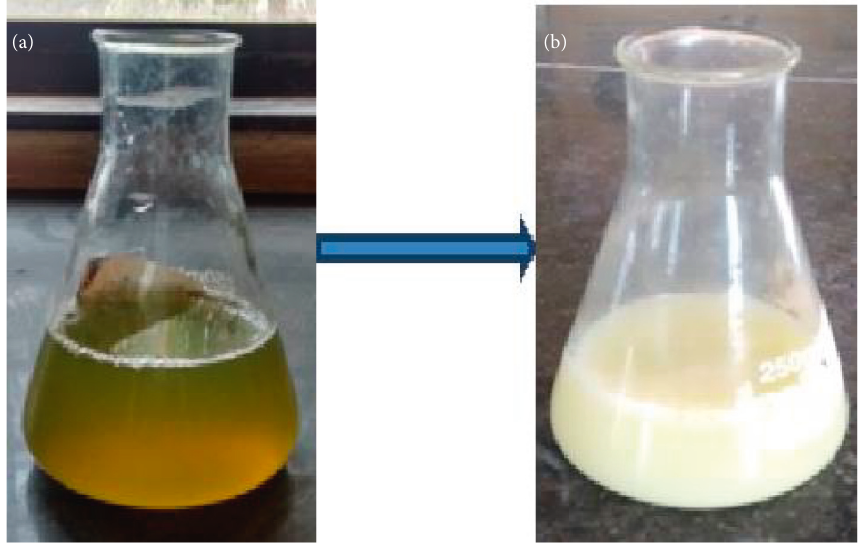
Figure 1: Synthesis of nanoparticles. (a) Leaf’s extract +zinc acetate. (b) Leaf’s extract +zinc acetate after 2 hrs.